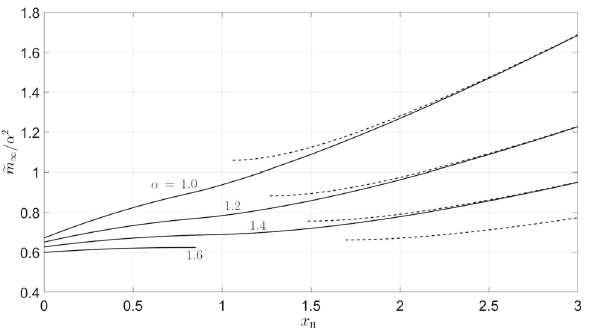
Fig. 6 The(normalized)massoftheEWSblackholesolutions (cid:13) m ∞ /α 2 as a function of the horizon radius x H for the values of coupling constant α = 1 . 0 , 1 . 2 , 1 . 4and1 . 6,togetherwiththecorrespondingRNsolutions with unit magnetic charge (dashed